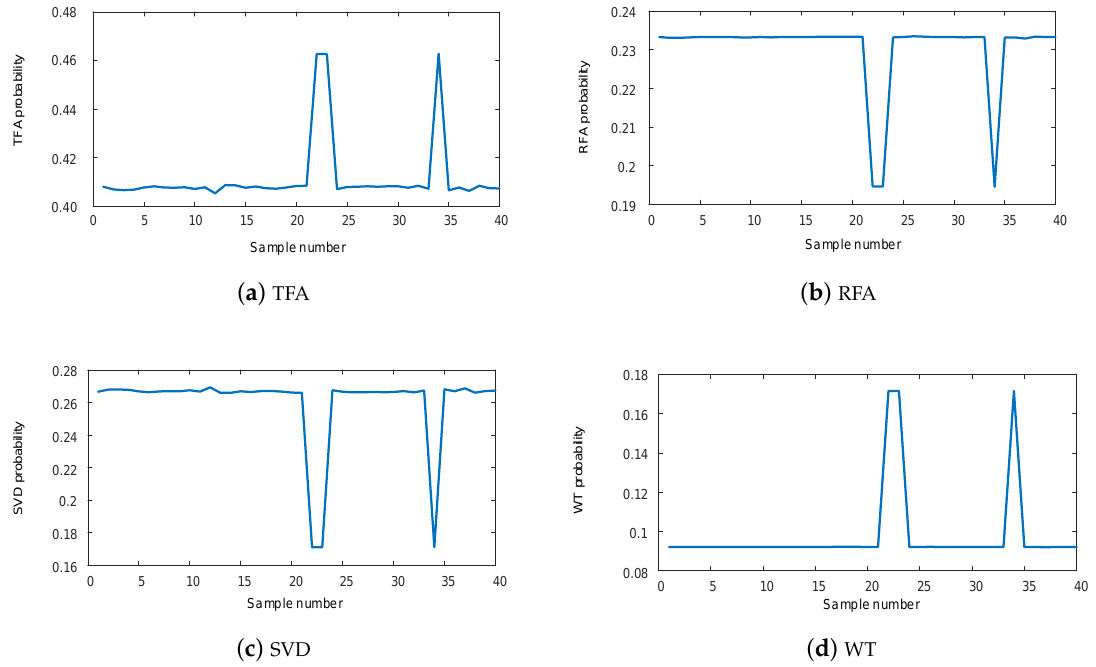
Figure 5. Probability of the TFA (triangular function algorithm) ( a ), RFA (rectangular function